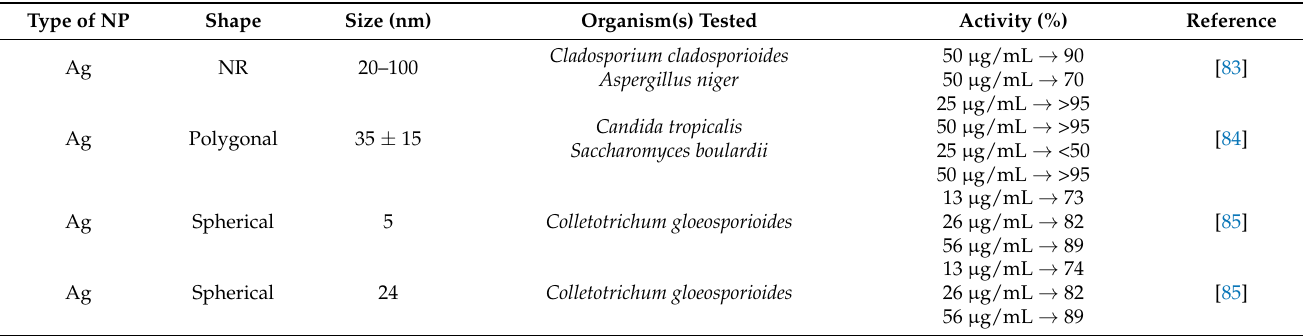
Table 6. Activities of NPs tested on different fungal species expressed as a